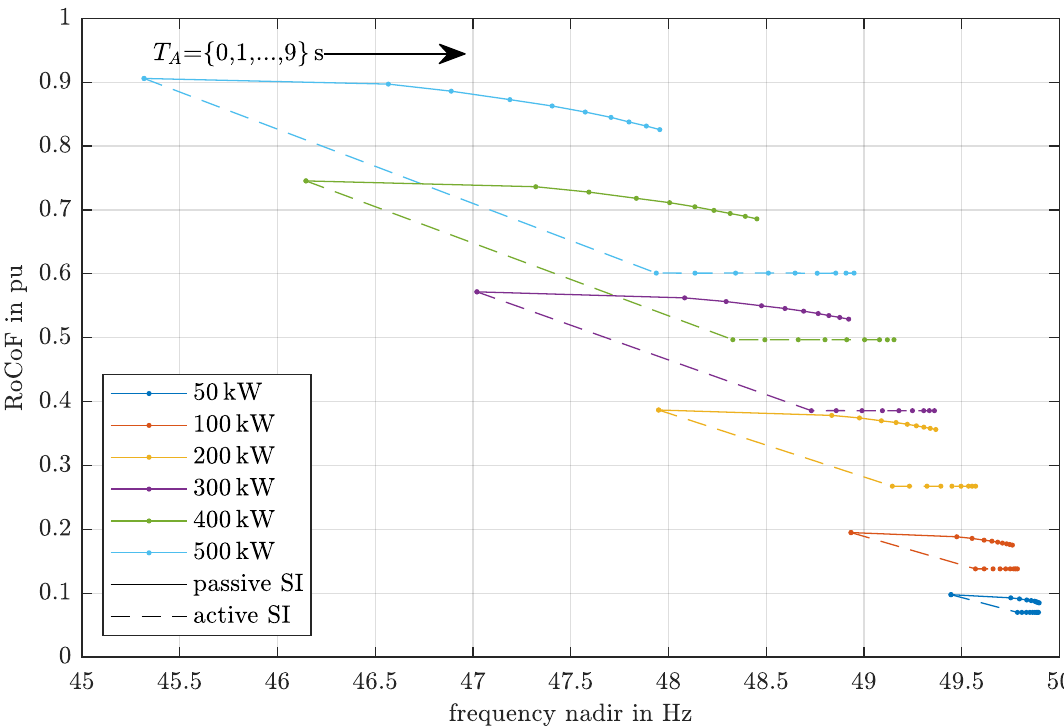
Figure 11. Comparison of the RoCoF over the frequency nadir for the sensitivity analysis of active- and passive synthetic inertia with varying starting time constants T A of the converter and different load-steps. The small points in the lines indicate the discrete values of the starting time constant which increases from left to right. The RoCoF is normalized to a value of 30Hzs − 1 . The high RoCoF values result from the relatively low inertia constant of the synchronous